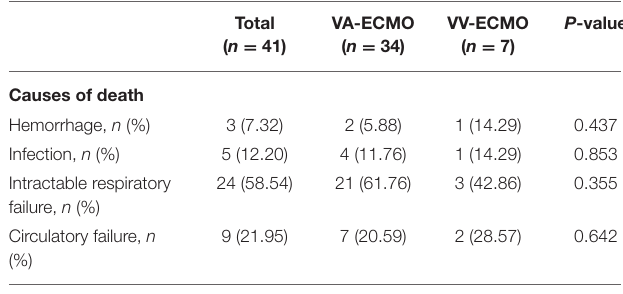
TABLE 2 | ECMO-related parameters (VA ECMO vs. VV ECMO). TABLE 3 | Causes of death (VA ECMO vs. VV